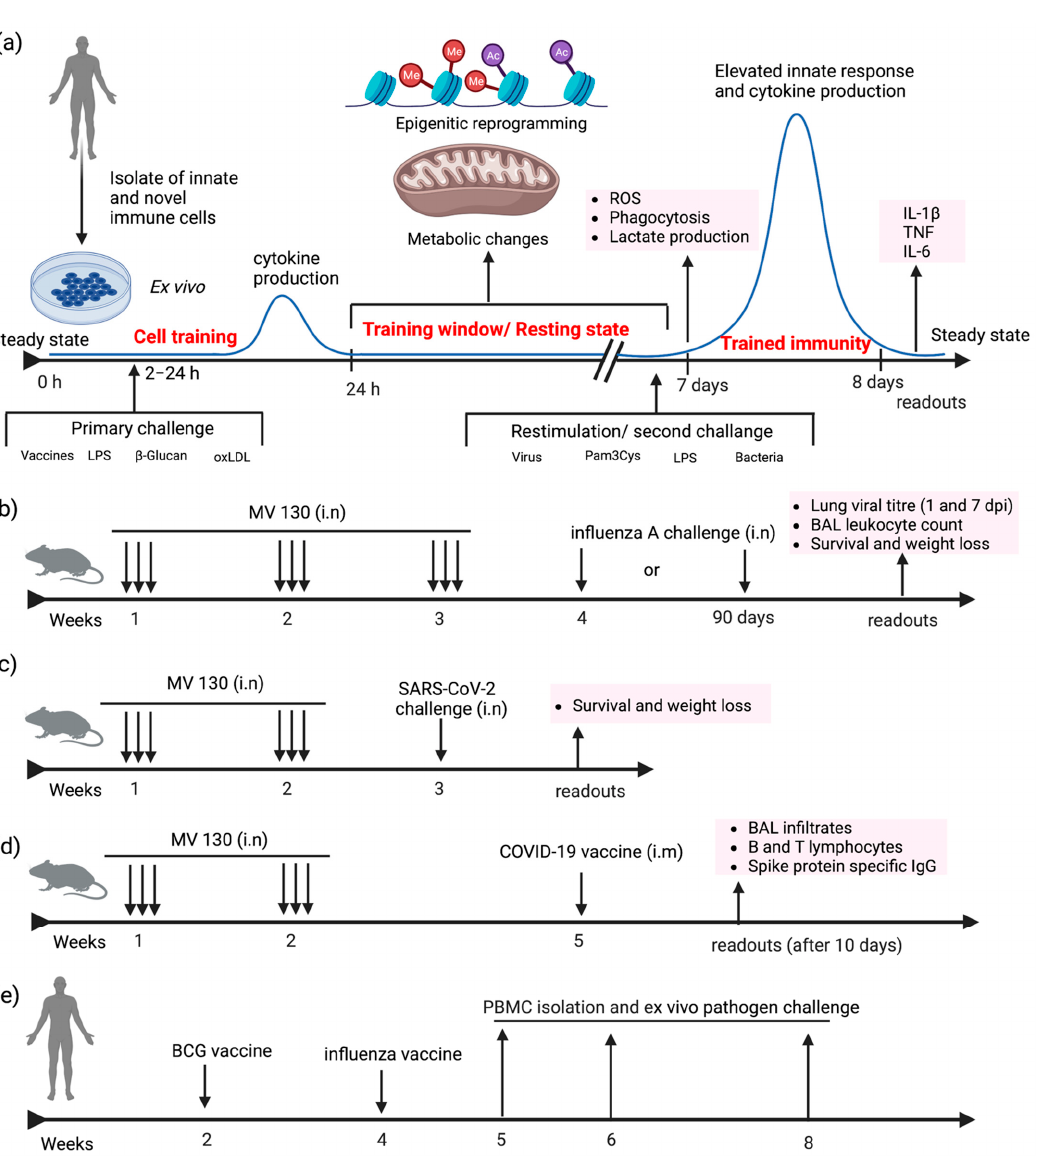
Figure 2. Examples of diverse experimental designs and models of trained immunity. ( a ) Ex vivo stimulation of innate immune cells isolated from humans. Cells are stimulated with vaccines or ad- juvants, and cytokine levels are quantified after 24 h. Culture media is replaced to remove the anti- gens, and cells undergo epigenetic and metabolic modification. After 5–7 days of the resting phase, cells produce heightened innate responses following a re-exposure to old/new stimuli. ( b – d ) Murine model to evaluate the immunological effect of MV130 against influenza A, SARS-CoV-2, or COVID- 19 vaccines [53,54] ( e ) Human model to investigate the effect of BCG on the influenza vaccine [60]. Numerous clinical trials have been conducted in neonates[61], adults, and the elderly population [62] to investigate the effect of BCG on trained immunity. The reprogramming